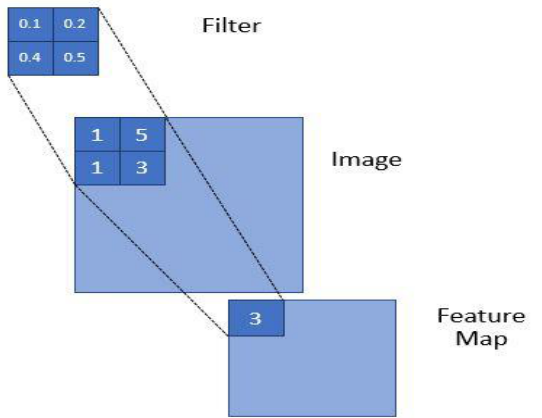
Figure 6. Example of a convolution layer which takes images/feature maps of previous layers as input and generates its own feature maps.